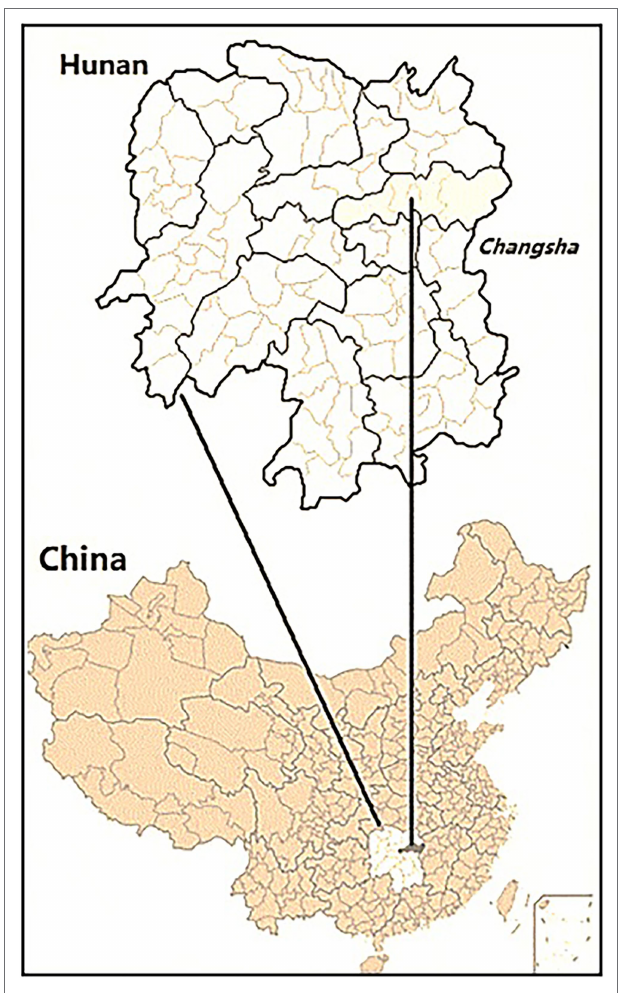
FIGURE 1 | Location of the study area, Hunan Botanical Garden in Changsha city, Hunan Province, China (113 ° 02 ′ -113 ° 03 ′ E, 28 ° 06 ′ -28 ° 07 ′